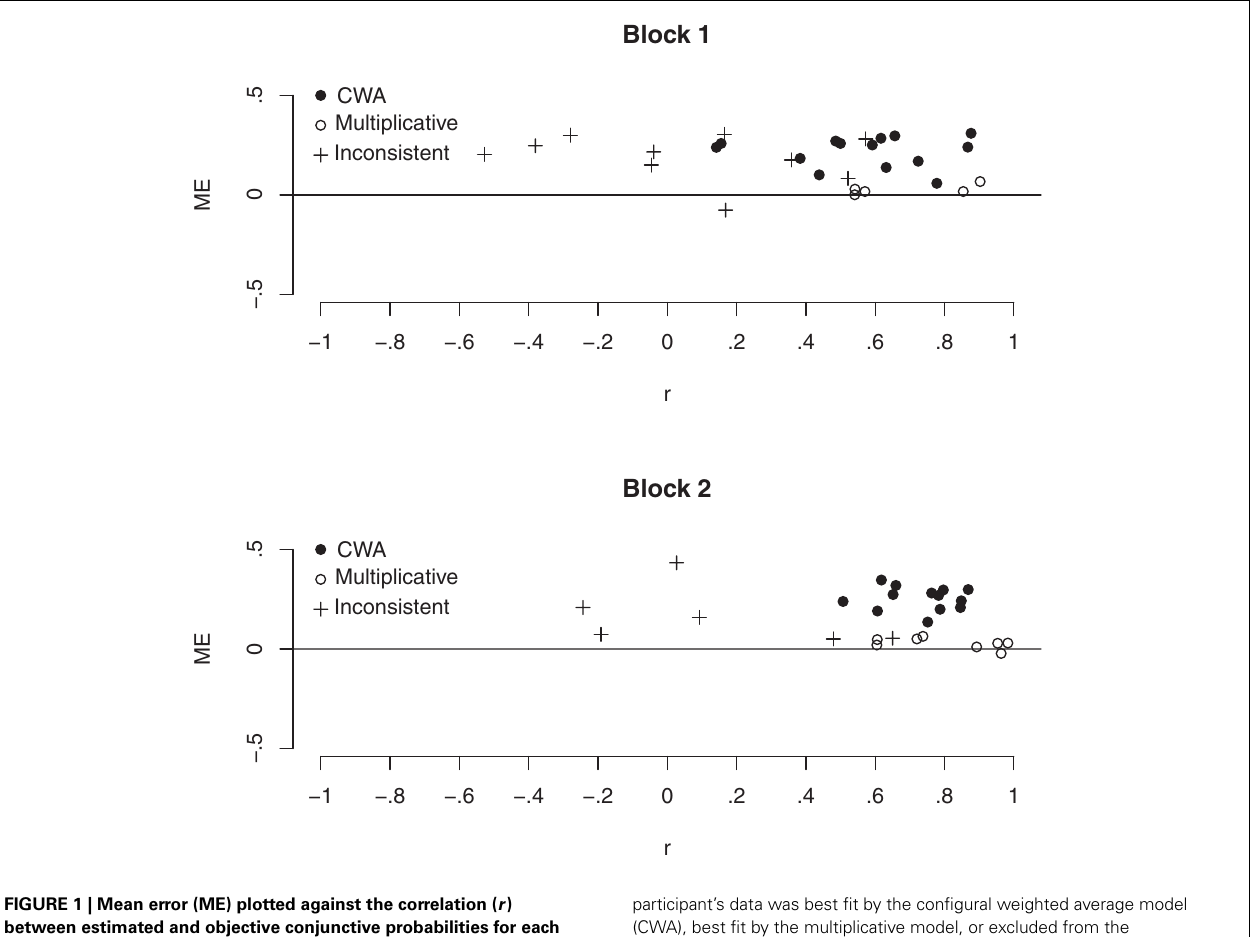
FIGURE 1 | Mean error (ME) plotted against the correlation ( r ) between estimated and objective conjunctive probabilities for each participant and block in Experiment 1. Symbols indicate whether the